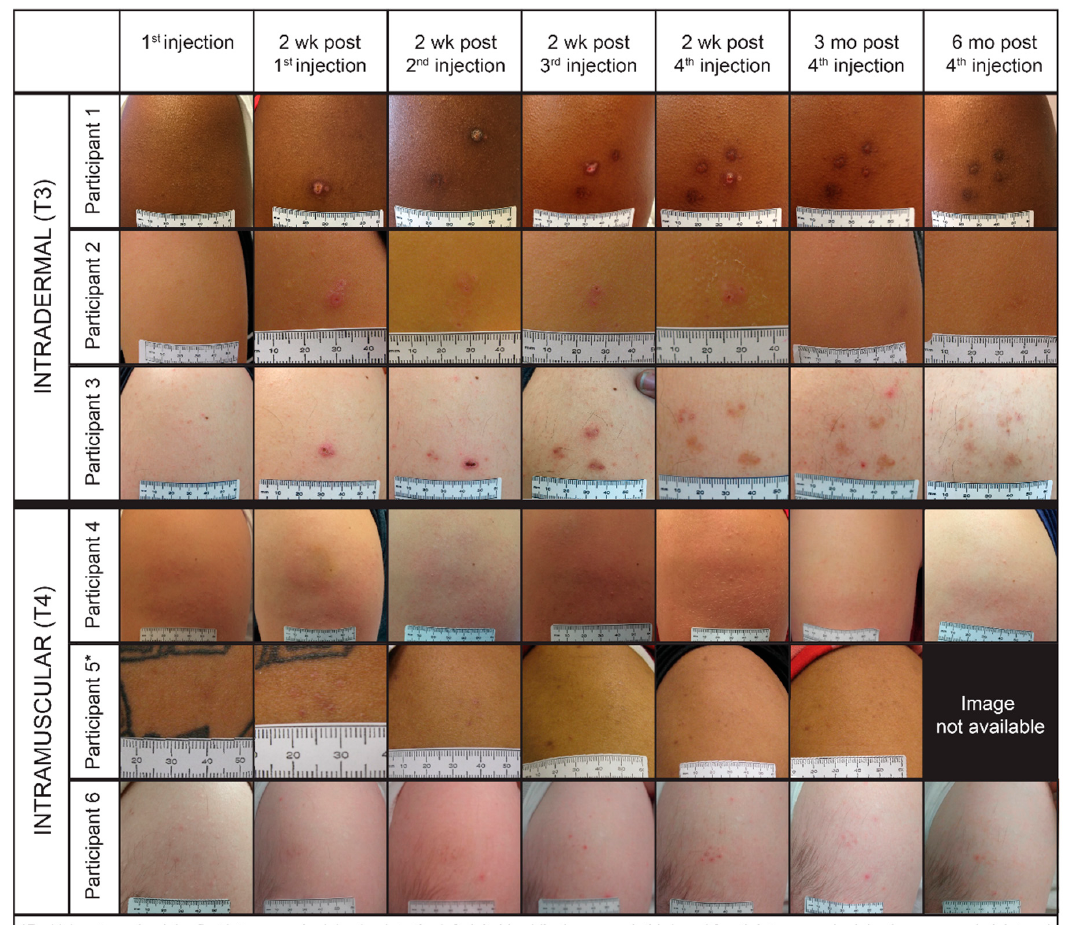
Figure 4. Injection site-related skin changes. Injection site-related skin changes shown in three representative participants from each of the intradermal and intramuscular groups. Wk = week; mo = month.